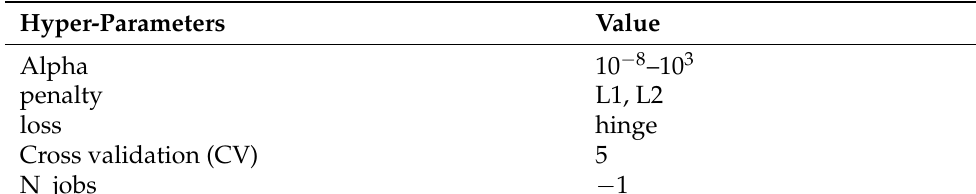
Table 6. Input Parameters for SVM.